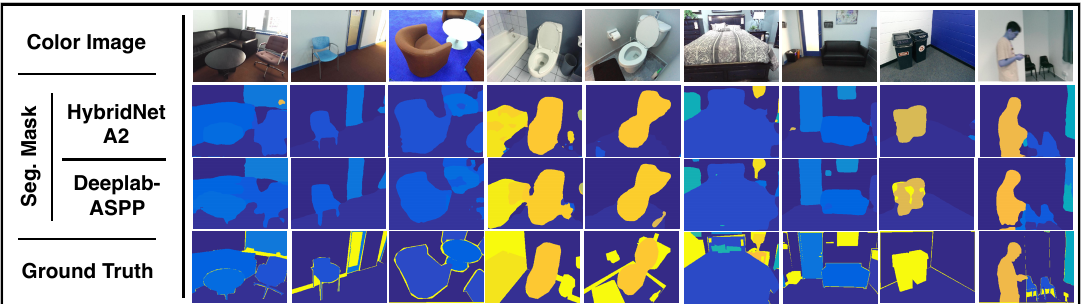
Figure 7. Semantic segmentation qualitative results. A comparison between semantic segmentation estimations against ground truth is presented. Input image is depicted in the first row. In the 2nd and 3rd row, the estimated segmentation mask obtained from HybridNet A2 and the ground truth are presented,